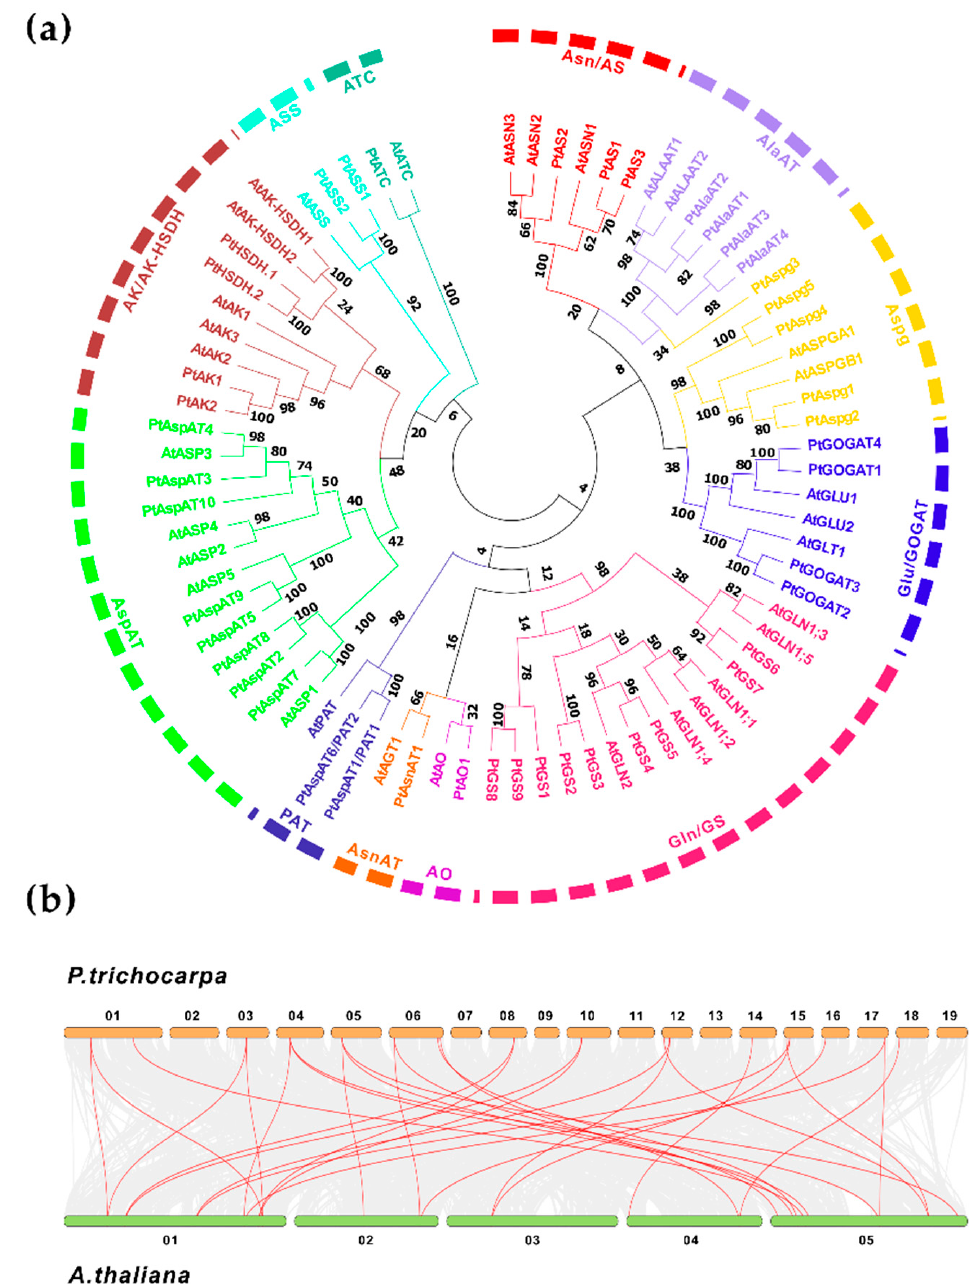
Figure 1. Phylogenetic relationships and collinearity of homologous isogenes between P. trichocarpa and A. thaliana . ( a ) The phylogeny shows relationships of clustered homologs. ( b ) The analysis shows the collinearity between the homologous isogenes. The unrooted phylogenetic tree was constructed by MEGAX using the Maximum Likelihood methods based on the 1000 bootstrap test.